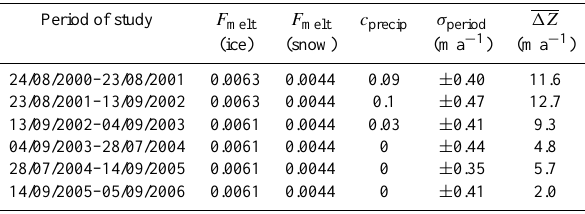
Table 4. Melt factors (md − 1 ◦ C − 1 ), c precip values, σ period and 1Z for the periods studied.